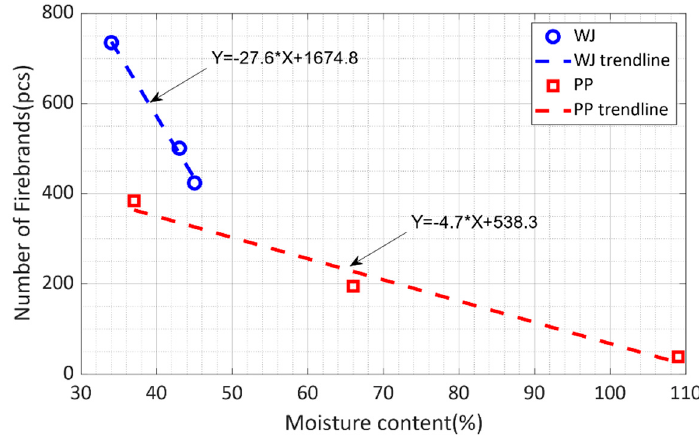
Figure 18. The number of firebrands generated varies the Fuel Moisture Content (FMC) of Western Juniper (WJ) and Ponderosa Pine (PP). Increasing FMC results decreasing in firebrand generation. The trend is linear, and it displays the equation of each trendline to find the number of firebrands generations in known FMC.